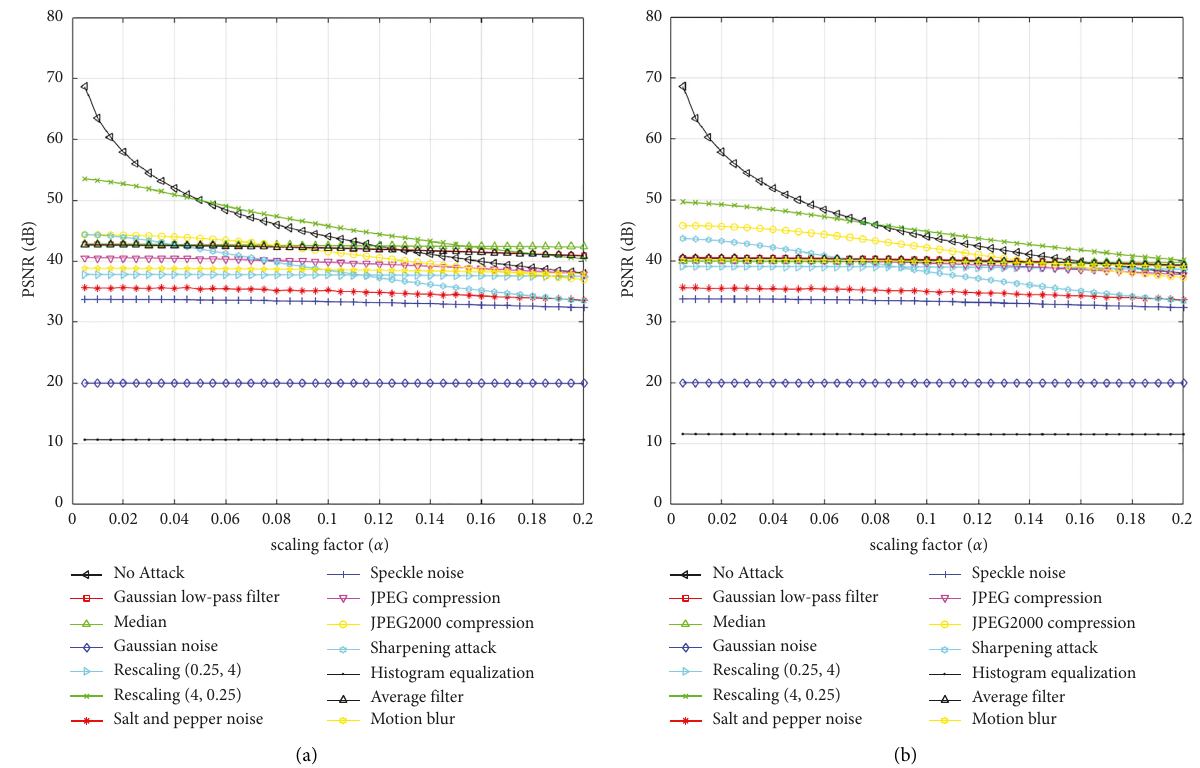
Figure 15: PSNR results of tests under different attacks according to scaling factor change. (a) Human blood. (b) Cancer cell line.